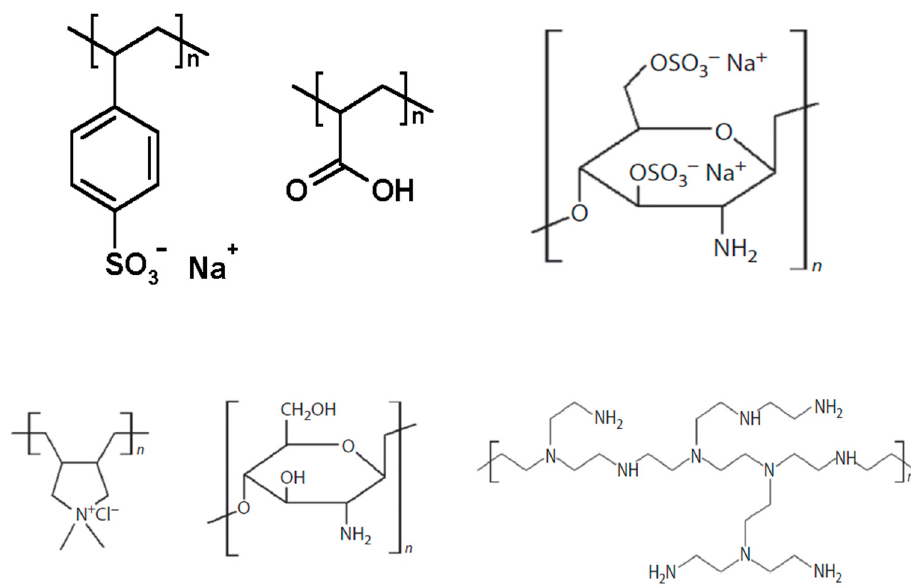
Figure 9. Schematic drawing of multi-layer polyelectrolyte deposition on the outer surface of a hol- low-fiber membrane (adapted with permission from [185]).